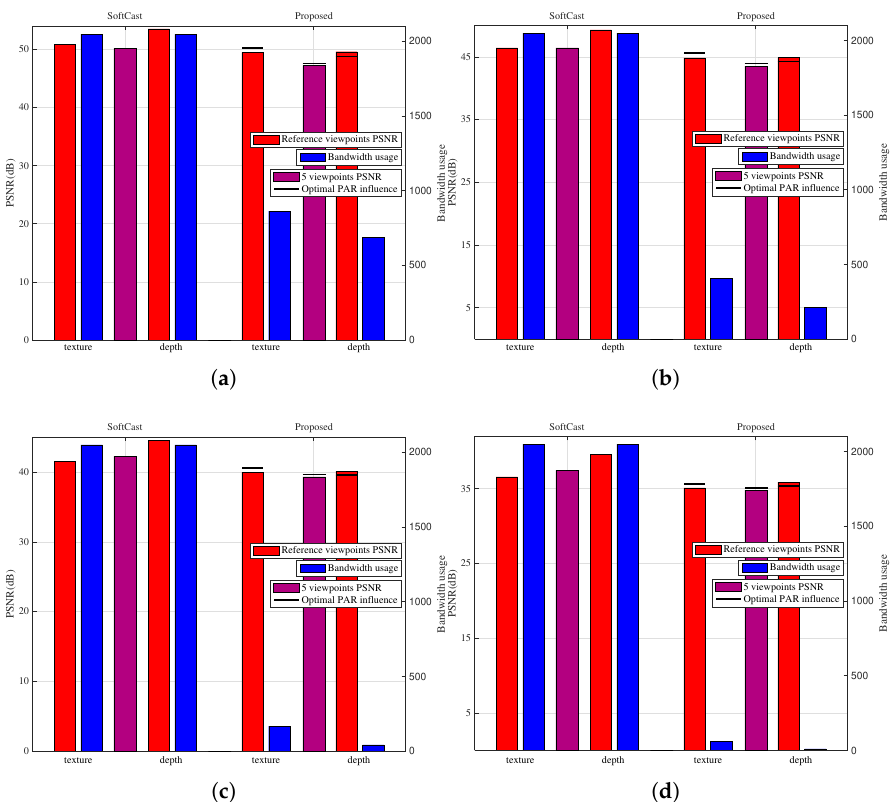
Figure 6. Bandwidth usage savings and PAR influence: ( a ) SNR chk = 20 dB (PSNR target = 50 dB); ( b ) SNR chk = 15 dB (PSNR target = 45 dB); ( c ) SNR chk = 10 dB (PSNR target = 40 dB); ( d ) SNR chk = 5 dB (PSNR target = 35